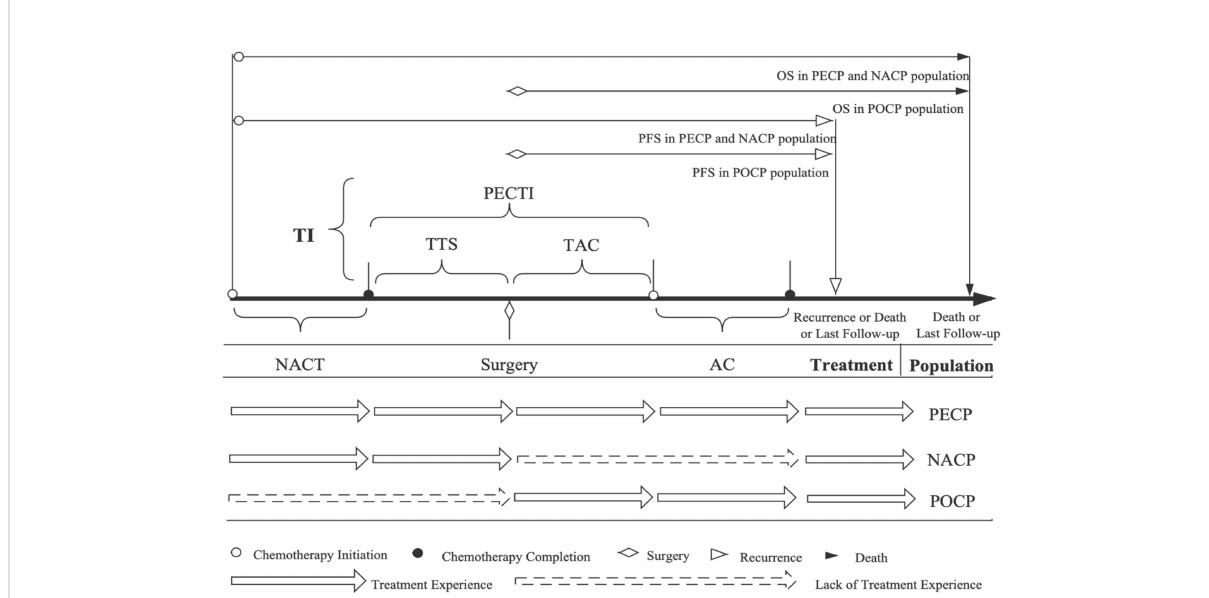
FIGURE 1 The de fi nition and illustration of chemotherapy-related time and population. The concept of ‘ TI ’ contains PECTI, TTS, TAC, and TTS plus TAC is equal to PECTI. Treatment consists of NACT, surgery, and AC. ‘ Population ’ contains PECP, NACP, and POCP. In the PECP and NACP populations, PFS is the period from the initiation of NACT to the recurrence, metastasis, death, or the last follow-up, and OS is to the death or the last follow-up. In the POCP population, PFS is the time span from surgery to recurrence, and OS is to death or the last follow-up. OS, overall survival; PFS, progression-free survival; TI, time interval; PECTI, perioperative chemotherapy time interval; TTS, time to surgery; TAC, time to adjuvant chemotherapy; NACT, neoadjuvant chemotherapy; AC, adjuvant chemotherapy; PECP, perioperative chemotherapy population; NACP, neoadjuvant chemotherapy population; POCP, postoperative chemotherapy